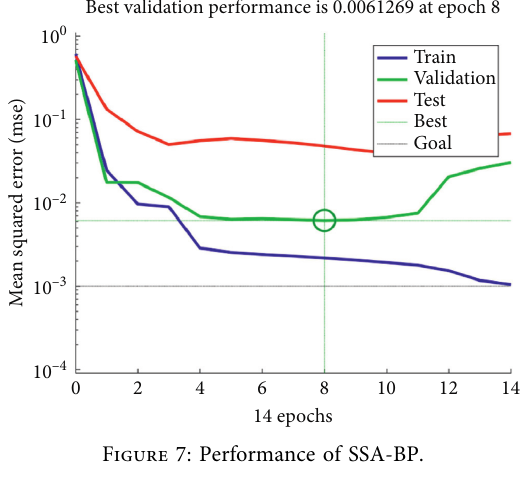
Figure 7: Performance of SSA-BP.